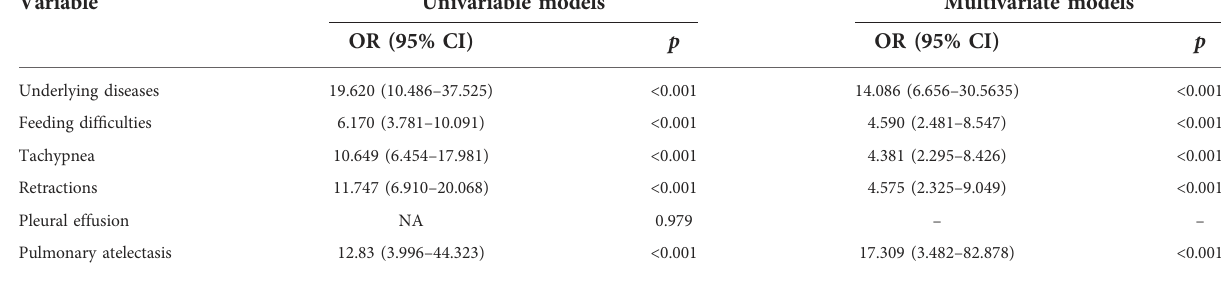
TABLE 2 Factors associated with apnea in fi nal multivariate regression model of training cohort.